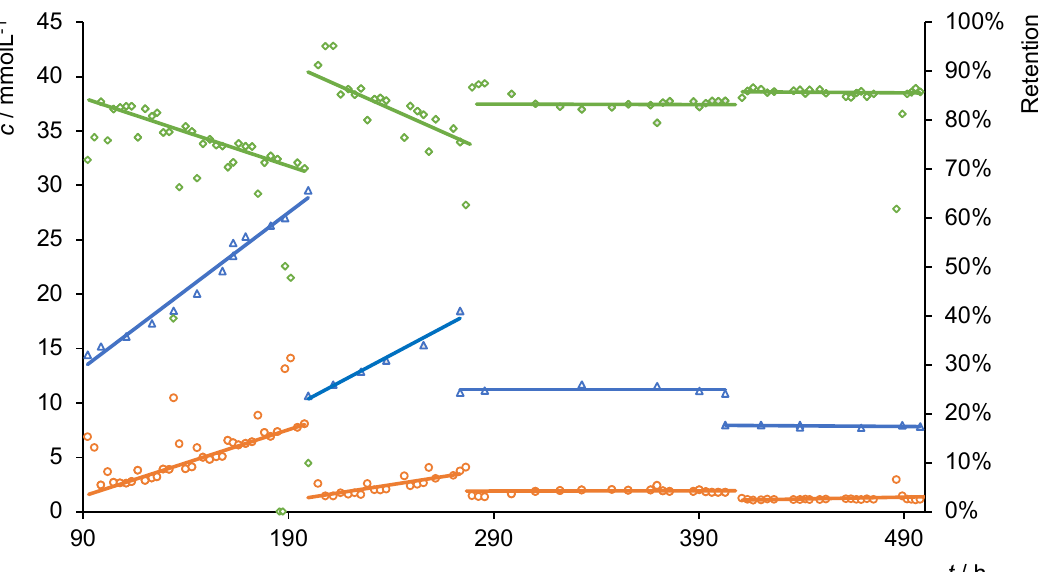
Figure 3. Retentate (blue triangles), filtrate (orange circles) and retention (green squares) in dead-end (90–270 h) and diafiltration experiments (270–490 h) using PILs BD2. Conditions: d membrane = 43.35 mm, p air = 6 bar, Schleicher&Schuell stirred dead-end cell, n [VBuIm]Br = 0.00465 mol, n [VDodecIm]Br = 0.00155 mol, n = 1:3:1, 5wt% TPO, 2wt% divinyl benzene (DVB) (wt% based on m IL : n ACN : n Styr 0.5 h ultrasonic bath, h gap = 300 µ m, 0.5 h UV lamp, 24 h EtOH, 24 h H 2